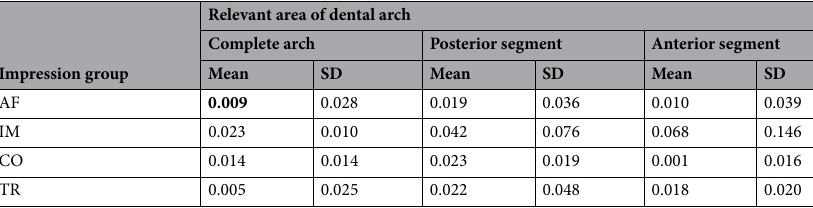
Table 1. Mean distance and standard deviation values of all impression groups: for complete arch, anterior and posterior segment in mm (n = 31). AF Affinis lab scan, IM Impregum lab scan, CO CEREC Omnicam, TR Trios 3, Mean mean distance, SD standard deviation.